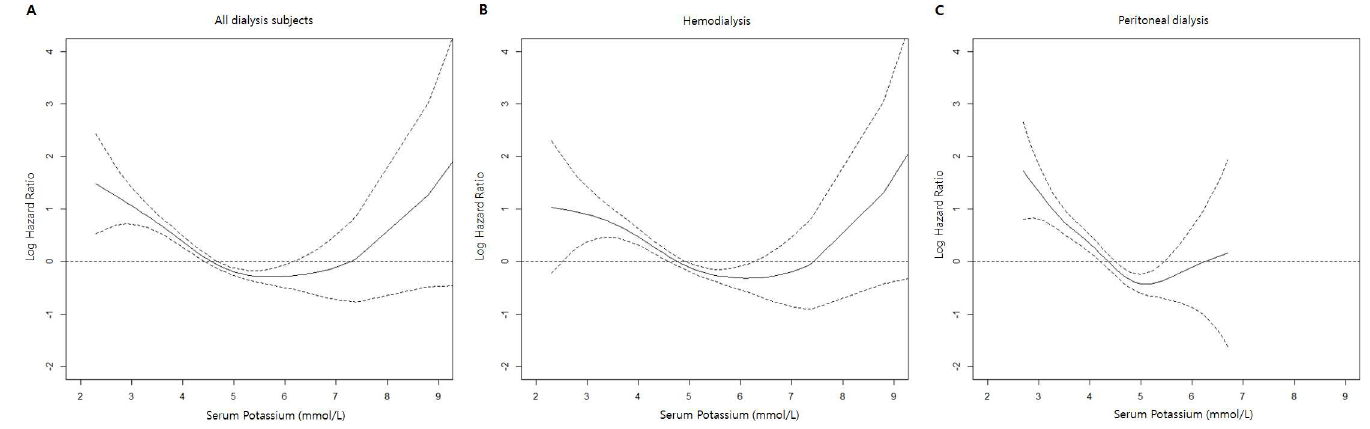
Fig 2. Log hazard ratio for overall mortality in relation to serum potassium in patients with end-stage renal disease. A) entire study cohort, B) patients undergoinghemodialysis, C) patients undergoingperitoneal dialysis.The solid line and dotted lines represent the central risk estimate and 95% confidenceintervals, respectively.